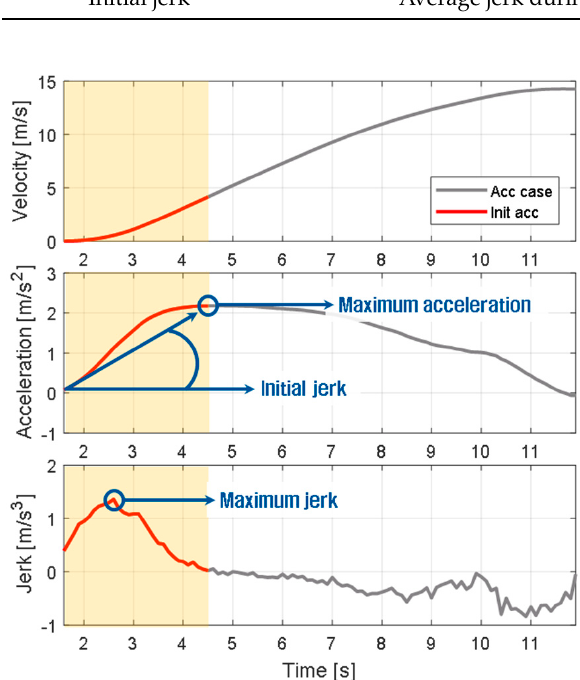
Figure 5. Definition of the initial acceleration section.